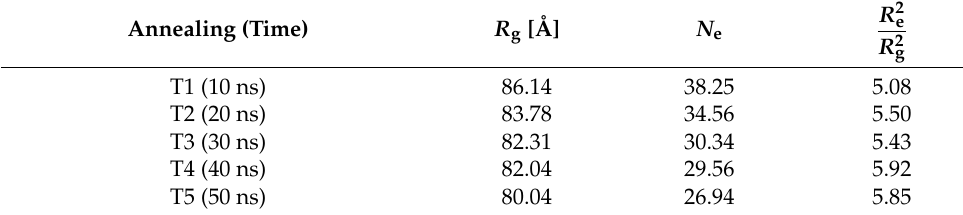
Table 2. Properties of simulation cells ( M n = 32.8 kg/mol, S4) with different annealing